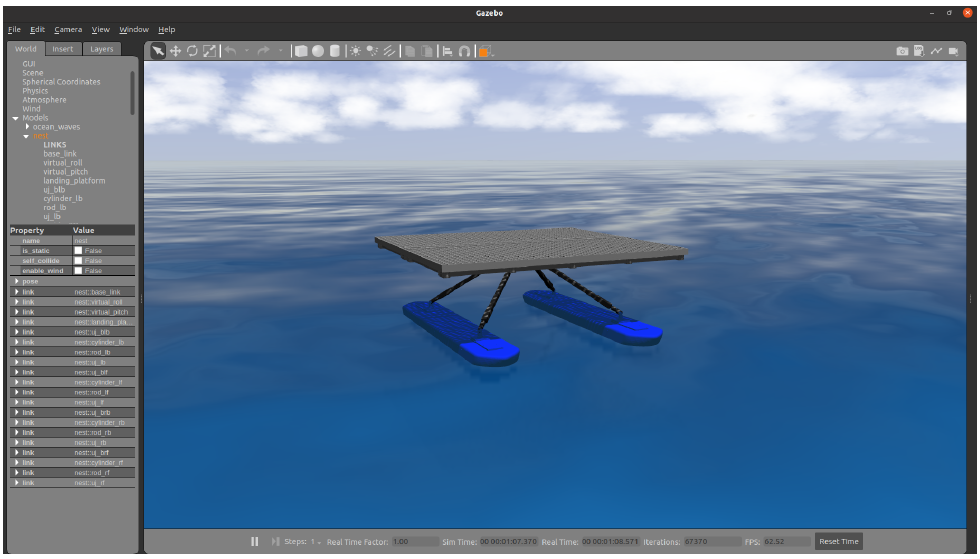
Figure 9. Screenshot of the simulator in Gazebo